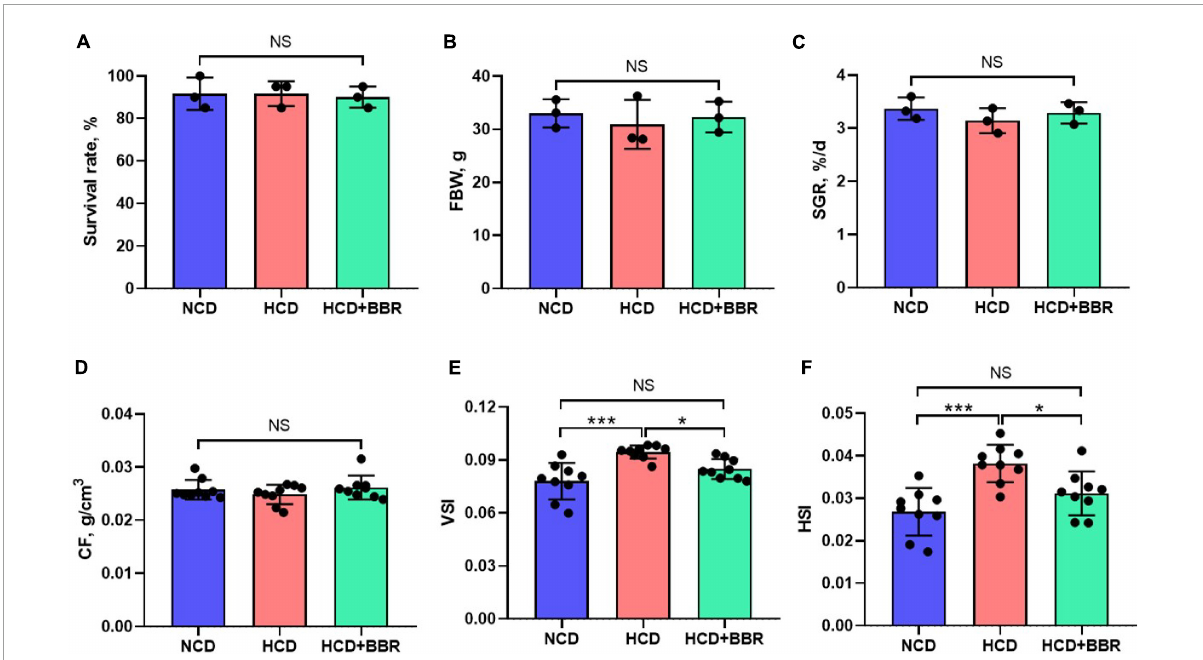
FIGURE1 Effects of dietary BBR on the survival rate (A) , growth performance (B,C) , and physical indexes (D–F) of largemouth bass. Data are represented as means ± SEM [ n = 3 for panels (A–C) , n = 9 for panels (D–F) ]. *, ***Different from each other: * P < 0.05, *** P < 0.001, NS means no significant difference (One-way ANOVA, Duncan’s post hoc